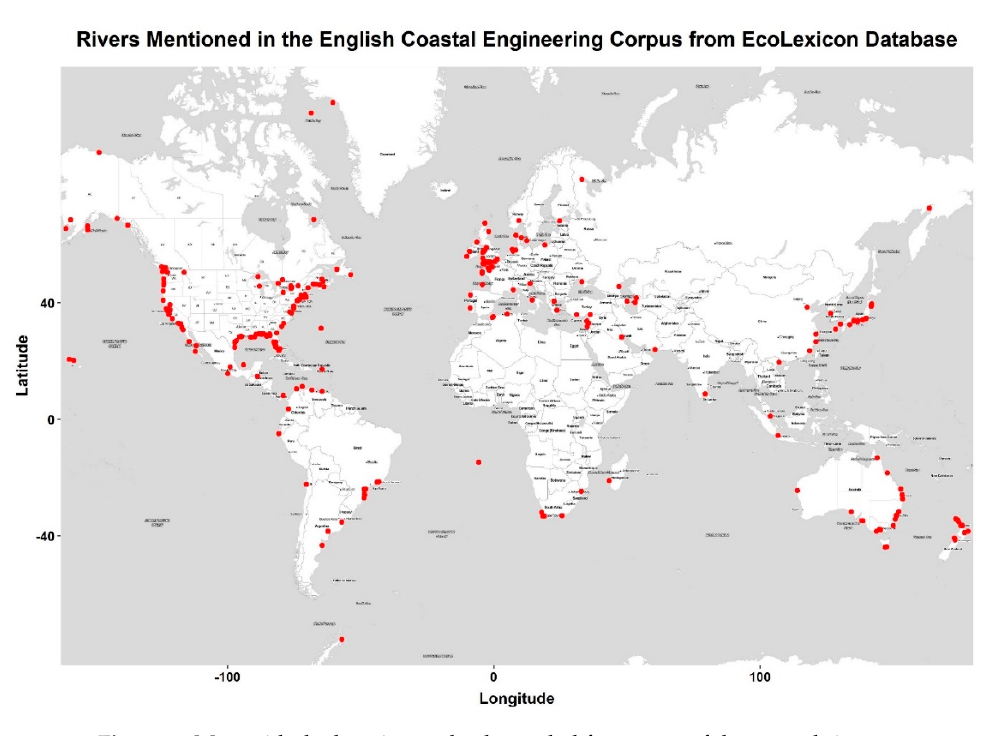
Figure 1. Map with the location and color-coded frequency of the named rivers.